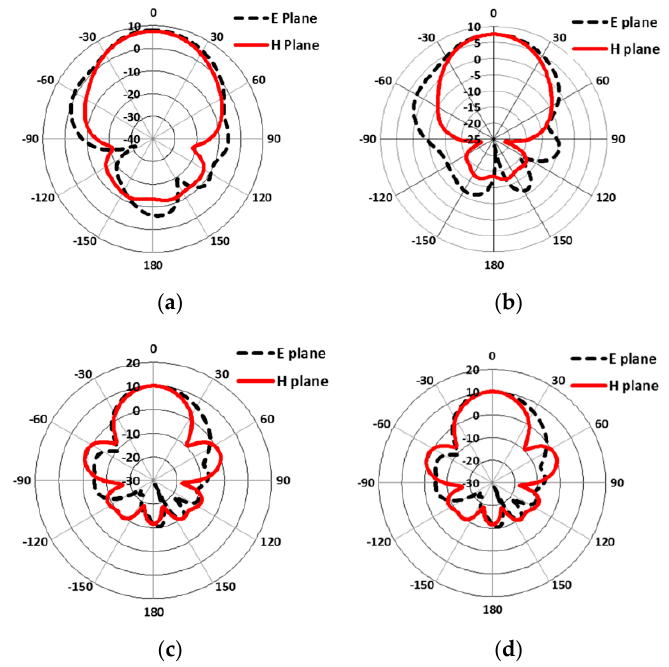
Figure 8. Gain plot in the E and H planes at ( a ) 193 THz; ( b ) 229 THz; ( c ) 353 THz; ( d ) 390 THz.